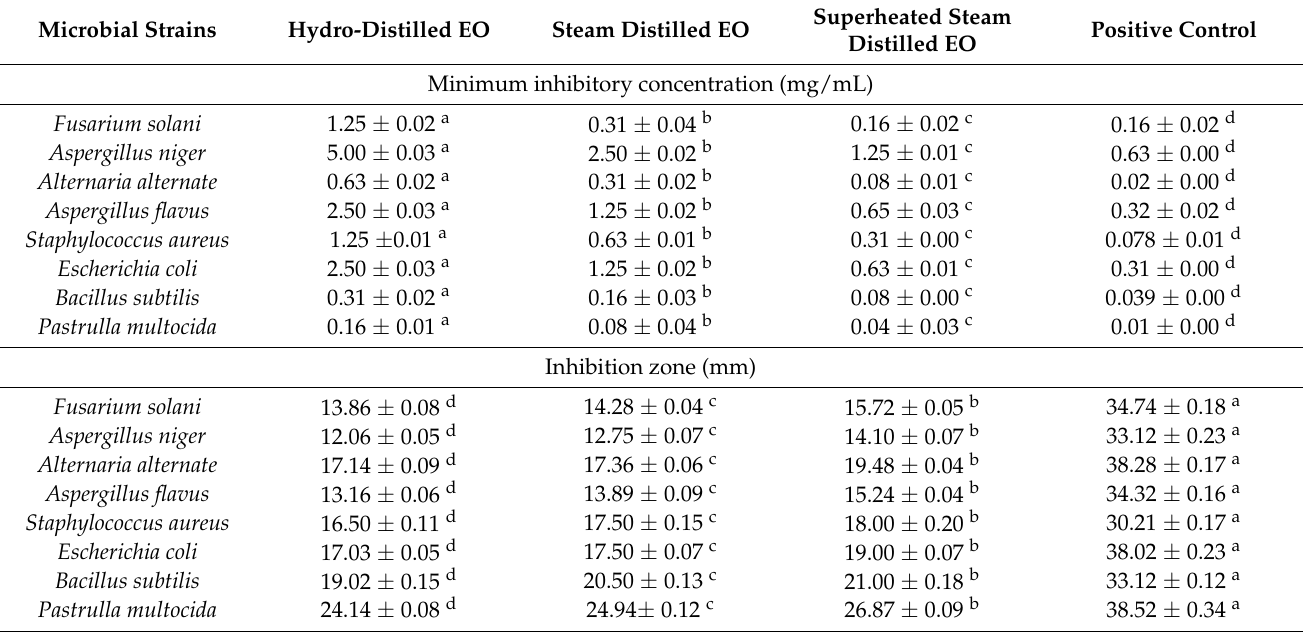
Table 1. Antimicrobial activity of S. aromaticum EOs derived from different extraction